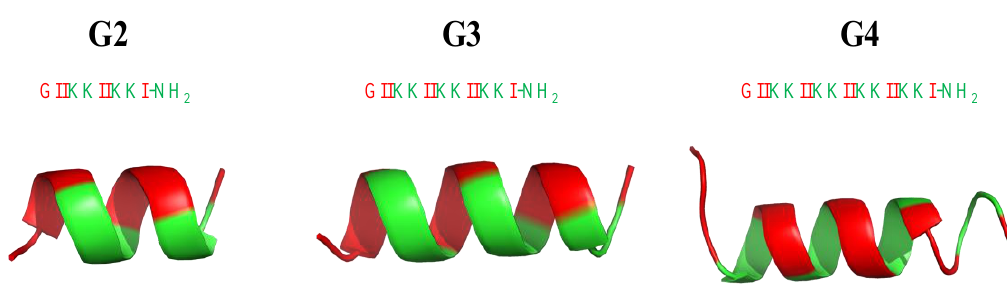
Figure 21. Secondary structure of G2, G3 and G4 peptides calculated with I-Tasser. In green: positively charged amino acids; in red: hydrophobic amino acids.